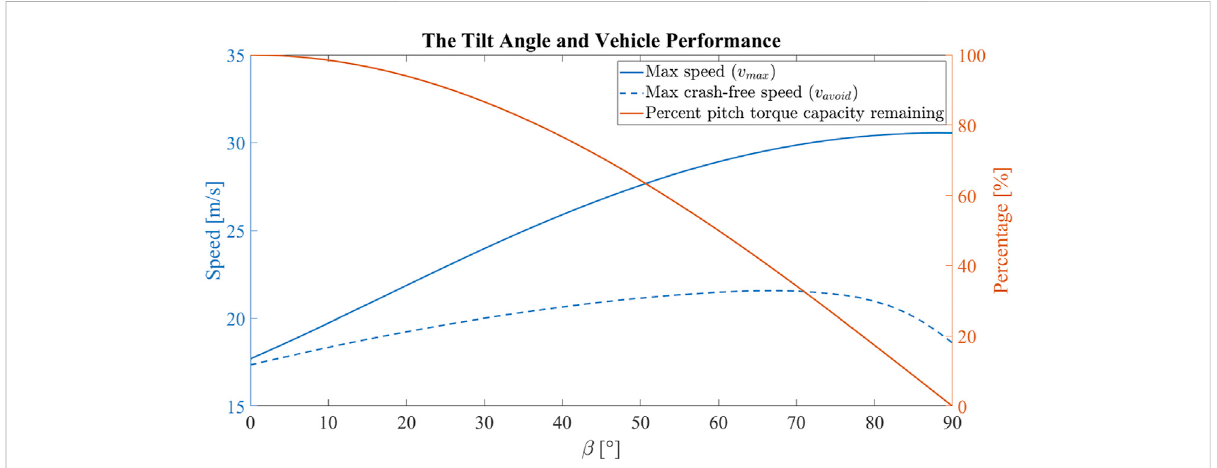
FIGURE 9 The correlation between the tilt angle and the vehicle performance for the experimental vehicle. Increasing the tilt angle increases the maximumcruisespeedofthevehiclewithadecreasingmarginalgain.Increasingthetiltangleincreasesthemaximumcrash-freecruisespeedofthe vehicle up until β = 68 ° . However, increasing the tilt angle decreases the pitch torque